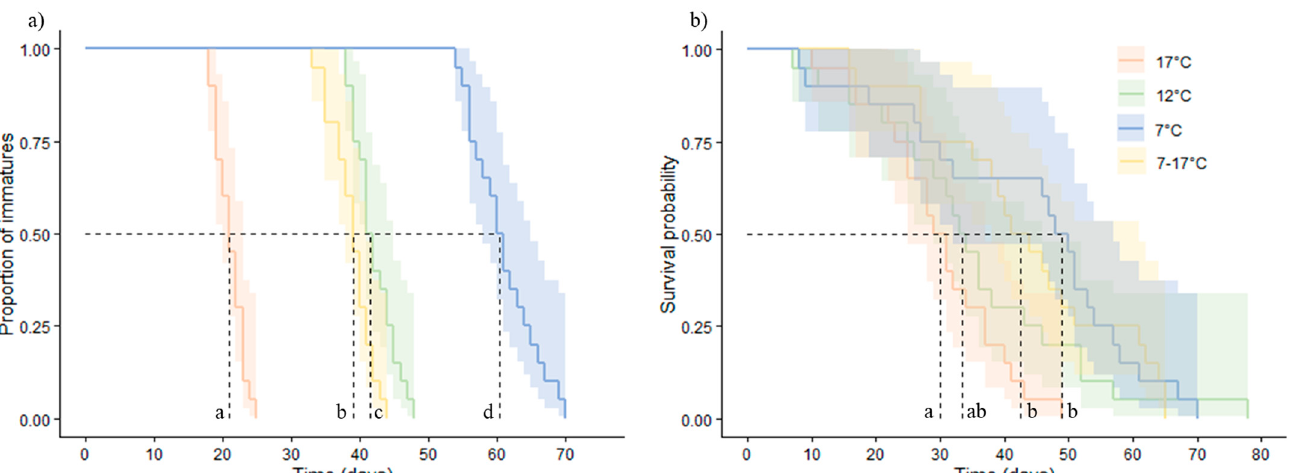
Figure 2. Proportion of immatures (i.e., development time to adulthood) ( a ) and adult survival probability ( b ) of Aphidius matricariae parasitoids exposed to three constant temperature regimes (7 °C, 12 °C, and 17 °C) and one fluctuating temper ‐ ature regime (7–17 °C) for data of the two sexes pooled together. Dotted lines represent the median estimate for each temperature. Colored areas represent 95% CIs around estimates for each temperature. Lowerscript letters indicate signif ‐ icant differences ( p < 0.05) among temperature regimes for each measured parameter. N = 20.